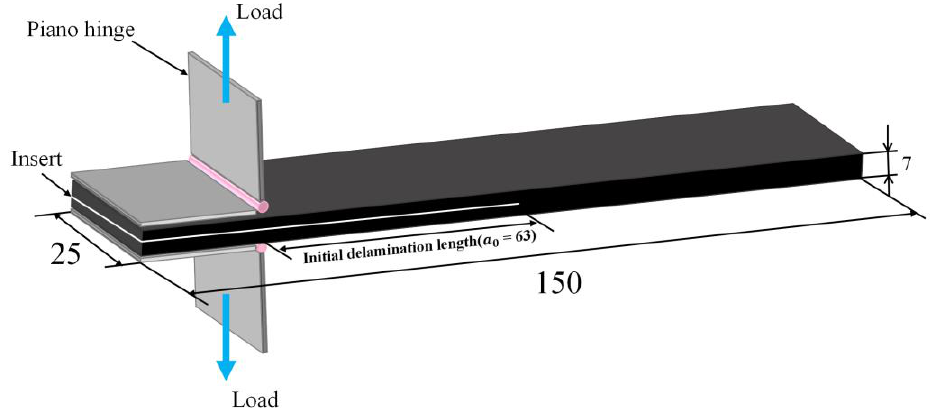
Figure 2. Schematic illustration of the DCB specimen and loading conditions (unit: mm).